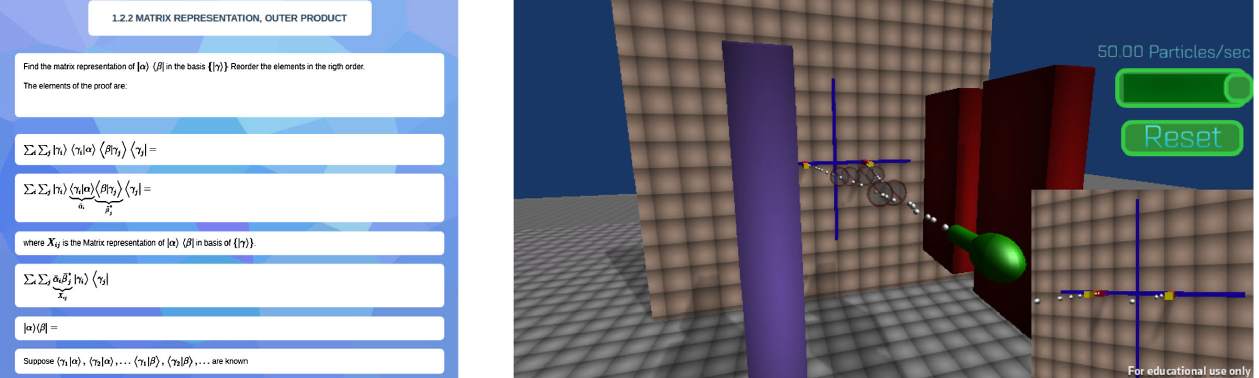
FIG. 2. Left: Example of a reshuffling exercise. The students had to drag the steps of the proof such that they were in the correct sequence. Right: Screenshot of the SGE simulator. The simulator allows the student to change the orientation of the magnets, to change the rate of particles, and to block certain spin components. When the particles hit the backscreen, a histogram of where the particles hit is